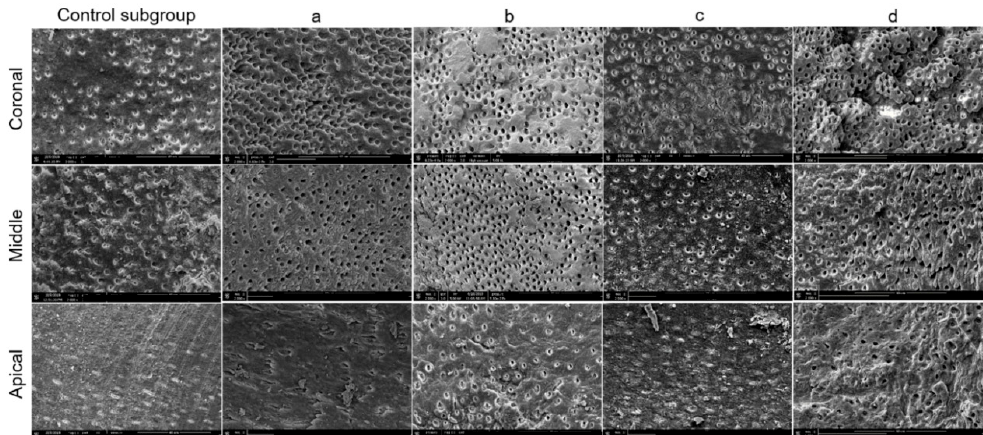
Figure 4. Representative scanning electron microscopy micrographs ( × 2000 magnification) of the coronal, middle, and apical thirds in samples from G1 (without pre-endodontic restoration). Five subgroups studied: (Control subgroup) Syringe and needles; ( a ) Endoactivator; ( b ) EQ-S; ( c ) XP-Endo finisher; ( d ) EndoUltra cordless.